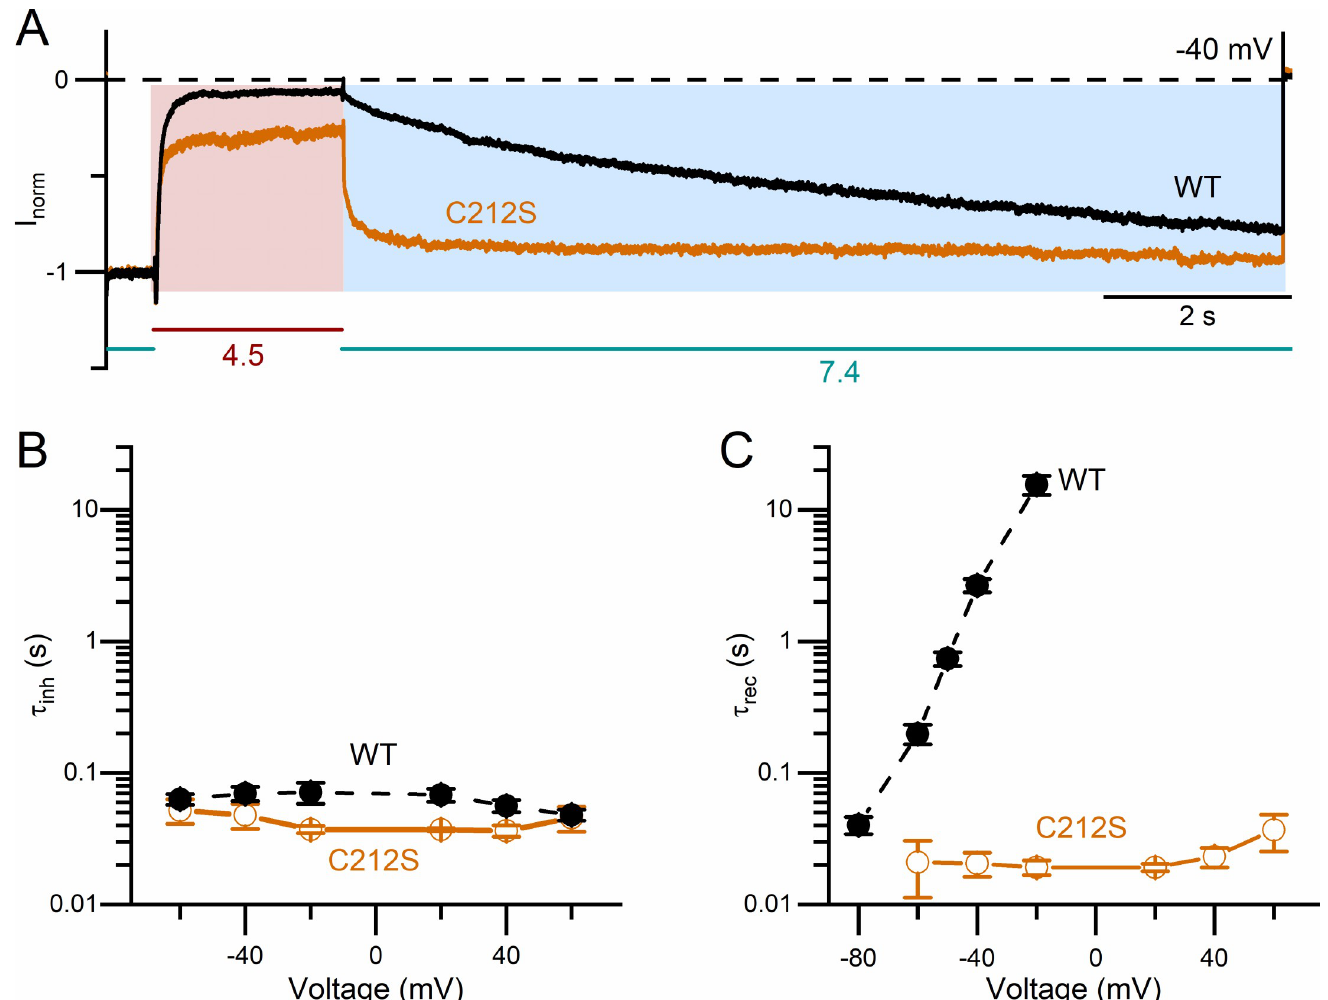
Fig 8. Comparing the voltage dependence of low pH i -induced inhibition between WT CLC-0 and the C212S mutant. (A) Recording traces showing the current inhibition induced by a solution with pH i = 4.5 in WT CLC-0 and C212S. V m = -40 mV. Values of the pH i were shown below the colored horizontal lines. The values of τ inh and τ rec were obtained by fitting the current inhibition process (region shaded in pink color) and the current recovery process (region shaded in light blue) to single-exponential functions. (B) Voltage dependence of τ inh of WT CLC-0 and C212S. All data points were obtained from the inhibition induced by a solution with pH i = 4.5 (n = 4–9). (C) Voltage dependence of τ rec of WT CLC-0 and C212S after pH i = 4.5 was switched back to pH i = 7.4 (n = 4–6). At positive voltages, current recovery was observed in the C212S mutant but not in WT